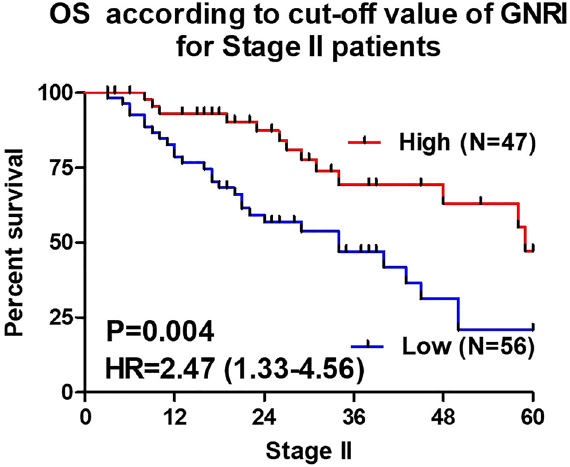
Figure 3. Overall survival curves between the Low and High GNRI groups in Stage II patients. OS is associated with a low GNRI level in Stage II patients.